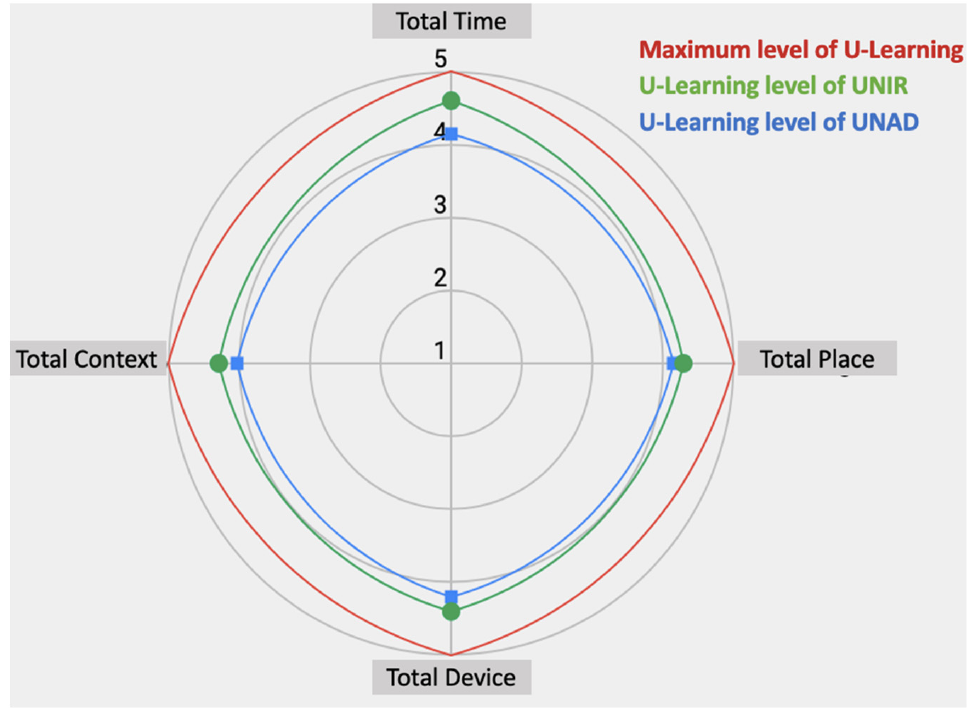
Figure 7. Comparison of the results [2].